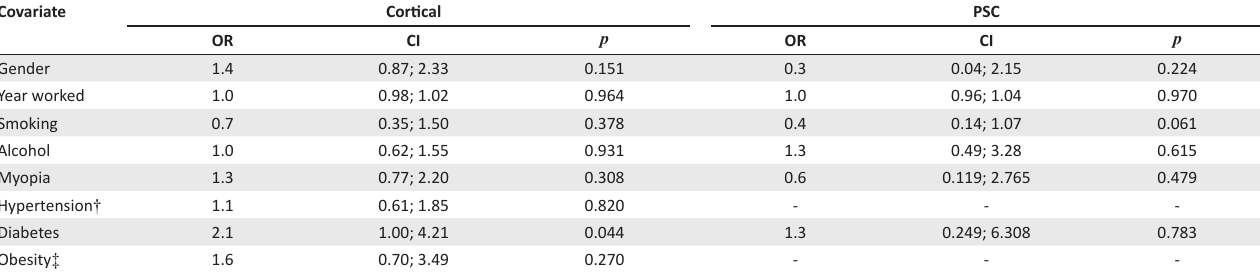
TABLE 2: The univariate analysis for cortical and posterior sub-capsular cataracts risk factors in all participants. Covariate Cortical PSC OR CI p OR